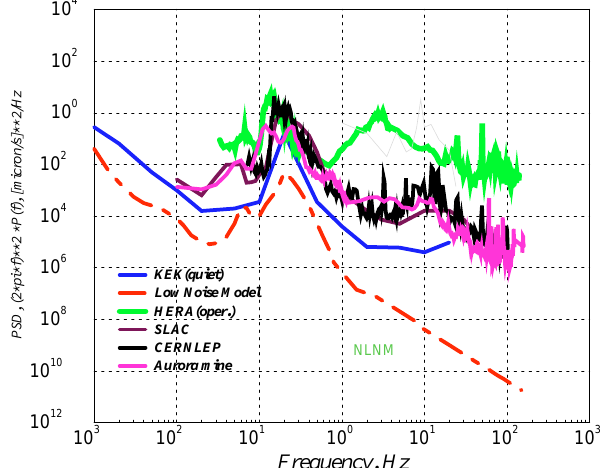
FIG. 20. (Color) Ground motion spectra at different accelerator sites and the USGS new low-noise